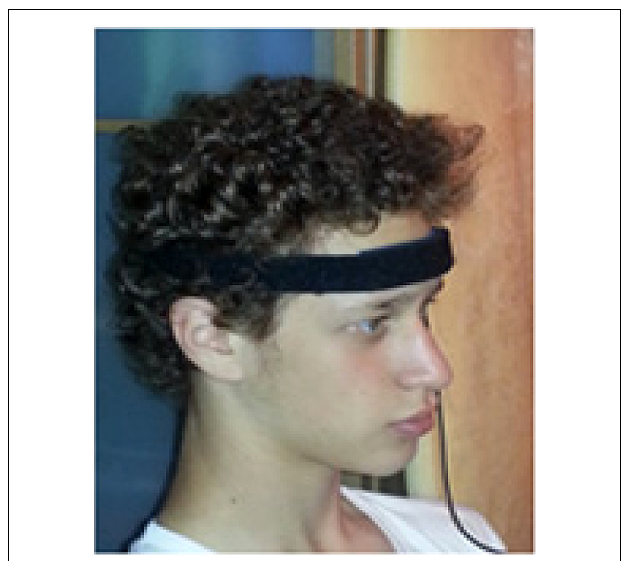
FIGURE 1 |The EEG